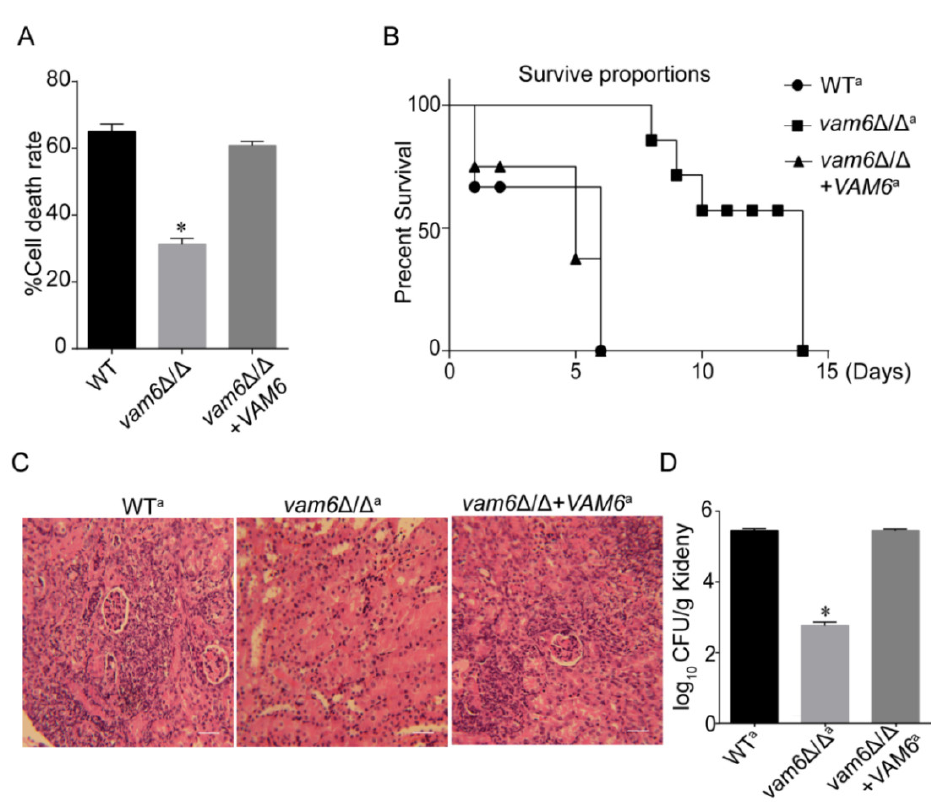
Figure 8. Effect of VAM6 deletion on virulence of C. albicans . ( A ) Macrophage-killing capacity of the strains WT a , vam6 ∆ / ∆ a , vam6 ∆ / ∆ + VAM6 a . ( B ) Survival rate of the mice infected by the strains. ( C ) Histopathological images of the kidneys infected by the strains. Bar = 50 μm. ( D ) Fungal burden in the kidney suffering from infection by the strains after five days. * indicates significant difference between the control strains and the mutant ( p < 0.05). Values represent mean ± SD.